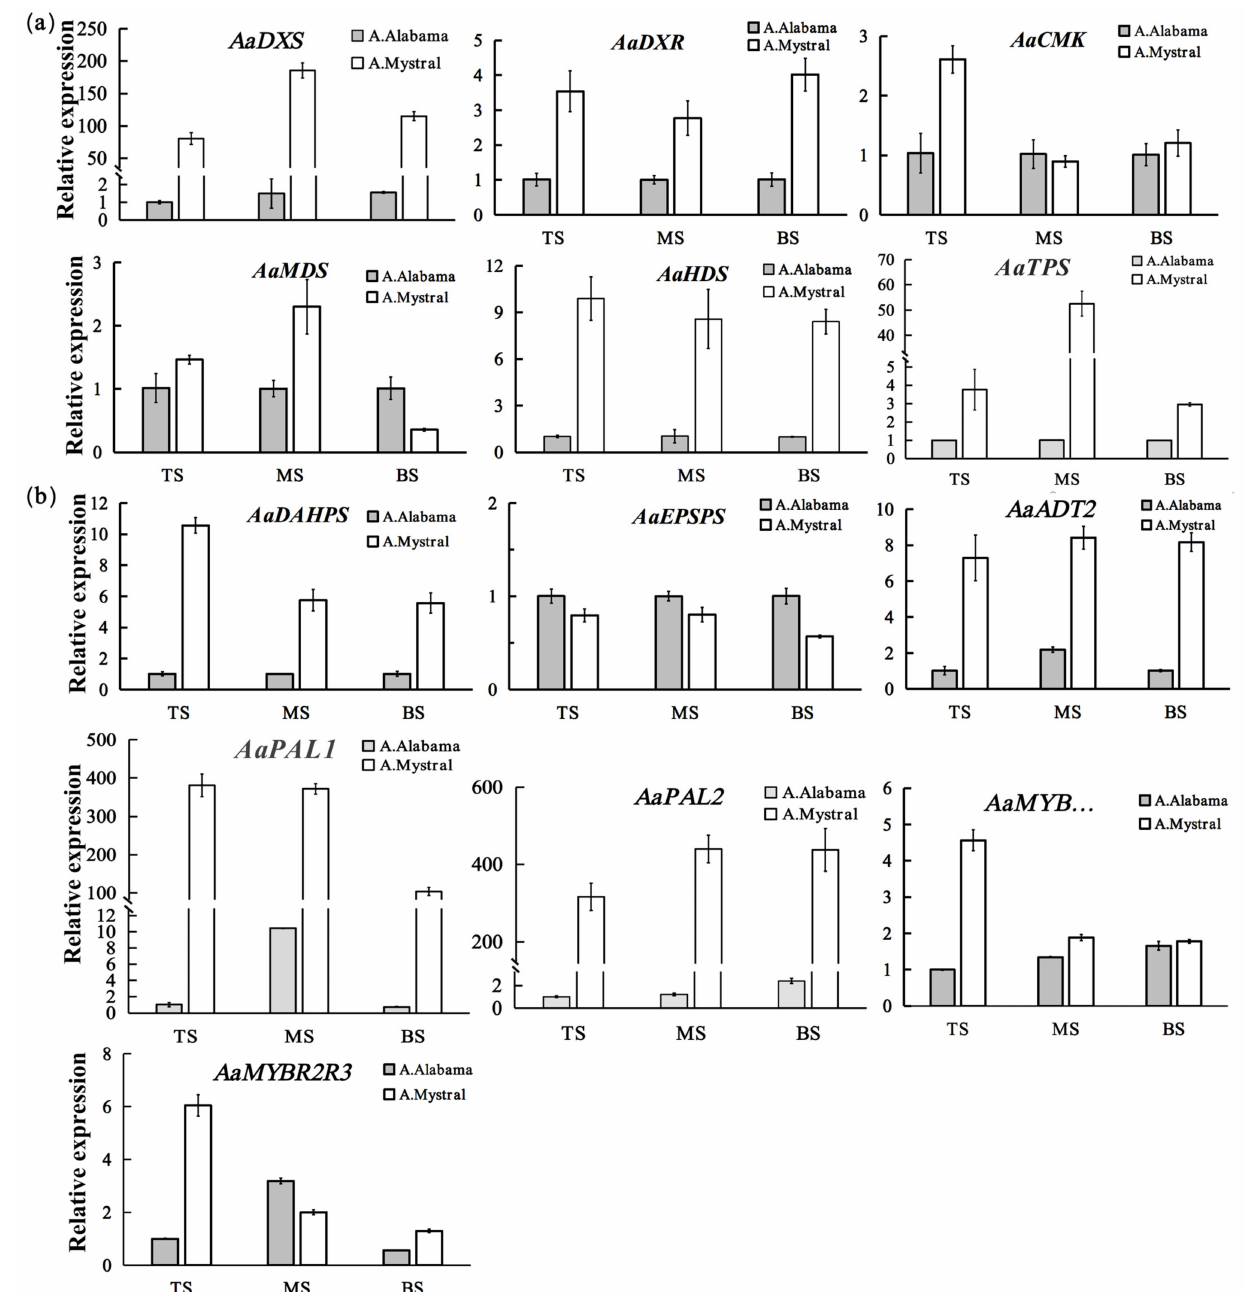
Figure 3. The relative expression levels of VOC biosynthesis-related genes in the inflorescences of A. ’Mystral’ and A. ‘Alabama’. ( a ) The relative expression levels of monoterpene biosynthesis-related genes; ( b ) The relative expression levels of key genes in the phenylpropane biosynthesis or shikimate pathways. TS, the top part of the inflorescences; MS, the middle part of the inflorescences; BS, the base part of the